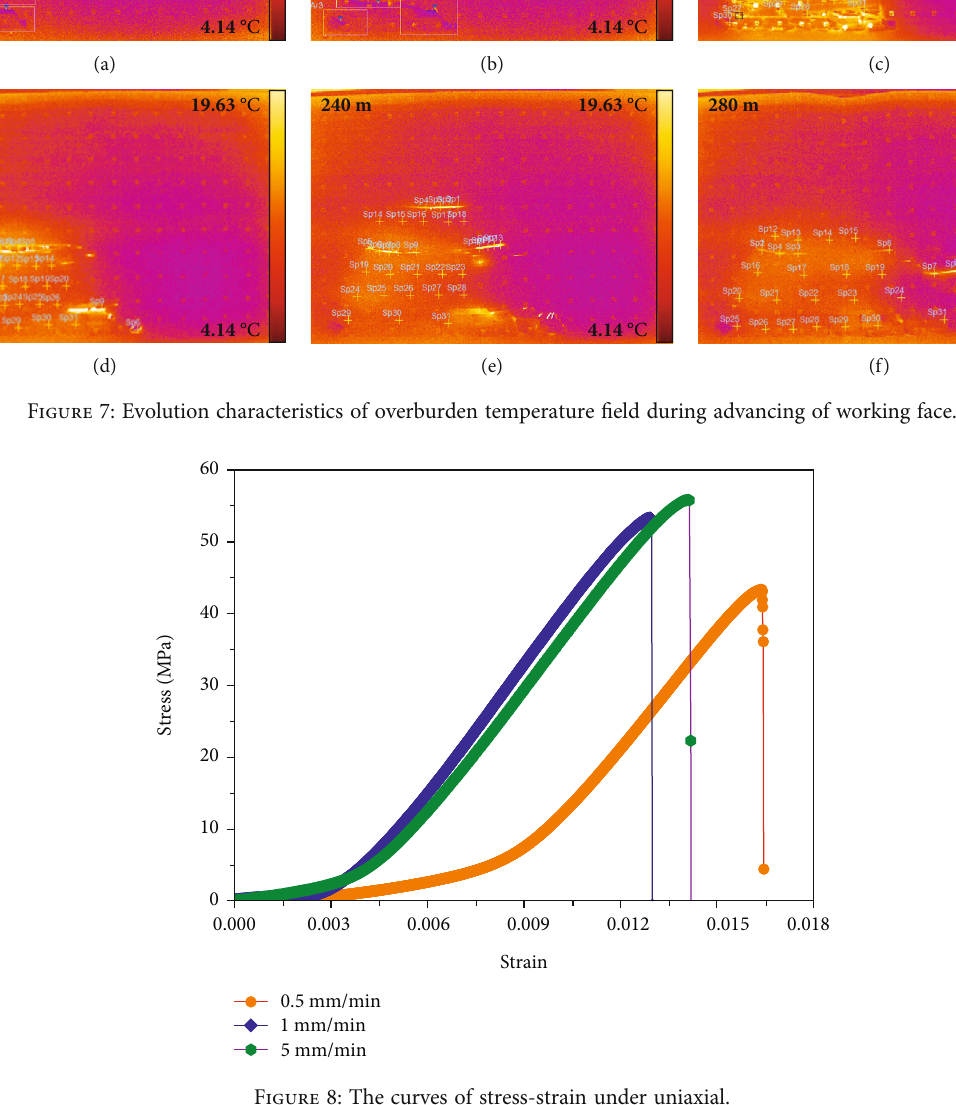
Figure 8: The curves of stress-strain under